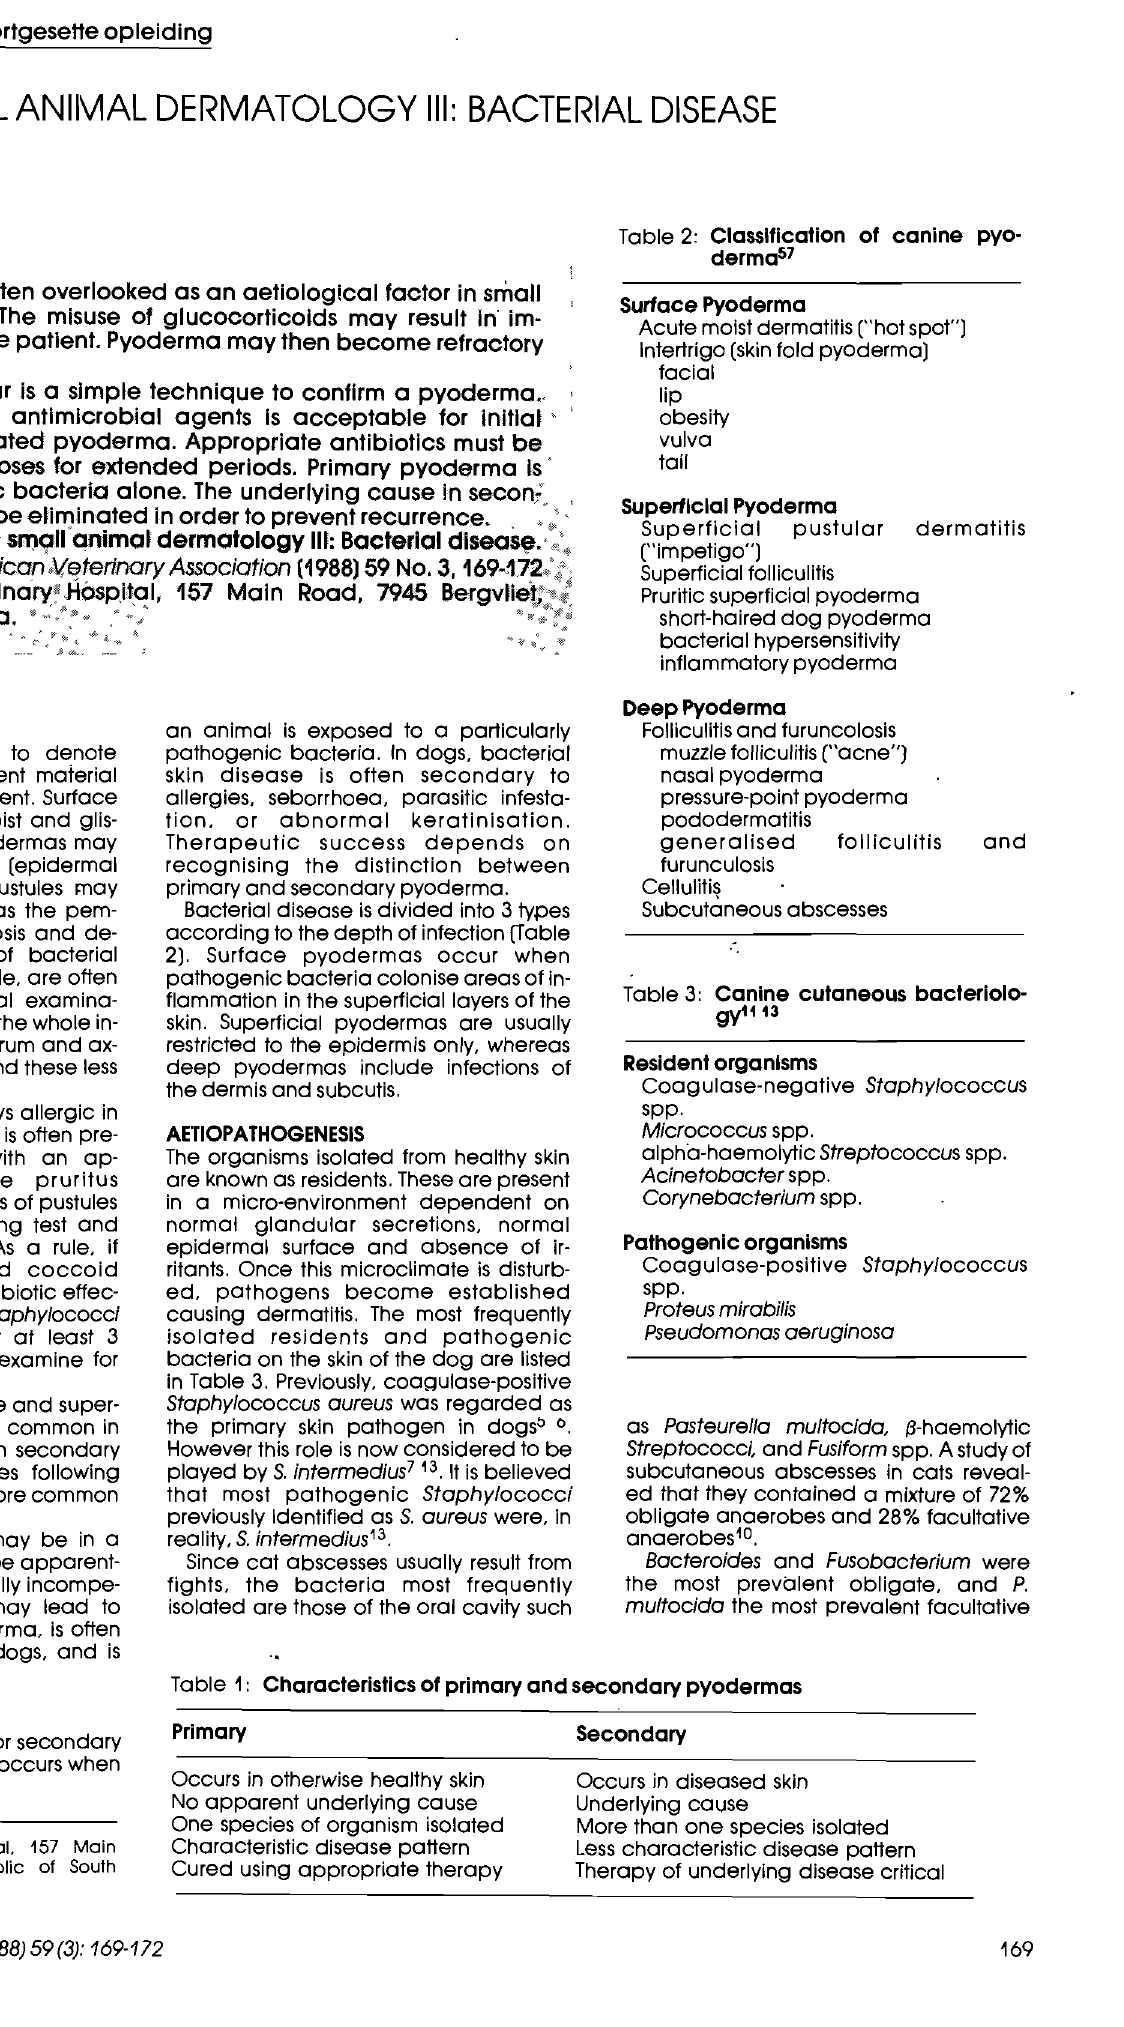
Table 2: Classification of canine pyo derma 57